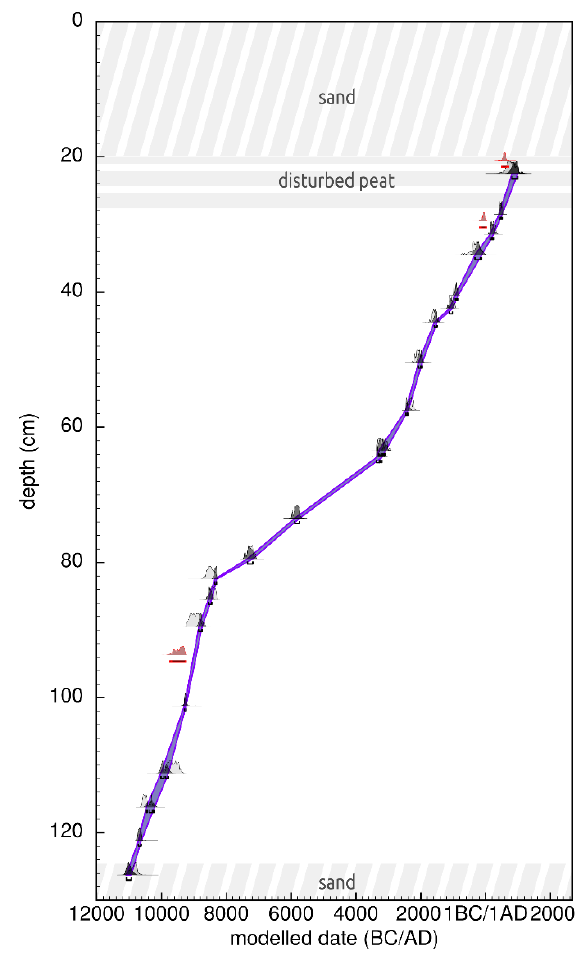
Figure 2. Age-depth model obtained with weighted mean of results from one Quantulus 1220 ™ and two ICELS systems. Purple curve presents 68 % highest probability density range. Distributions for the single weighted calibrated dates are marked with light grey. Posterior distributions are marked with dark grey which takes into account the age-depth model. The outliers are marked in